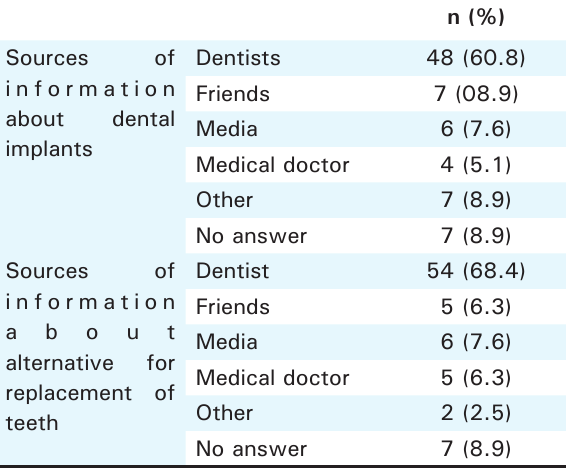
Table 5. Sources of information about alternatives for replacement of teeth.